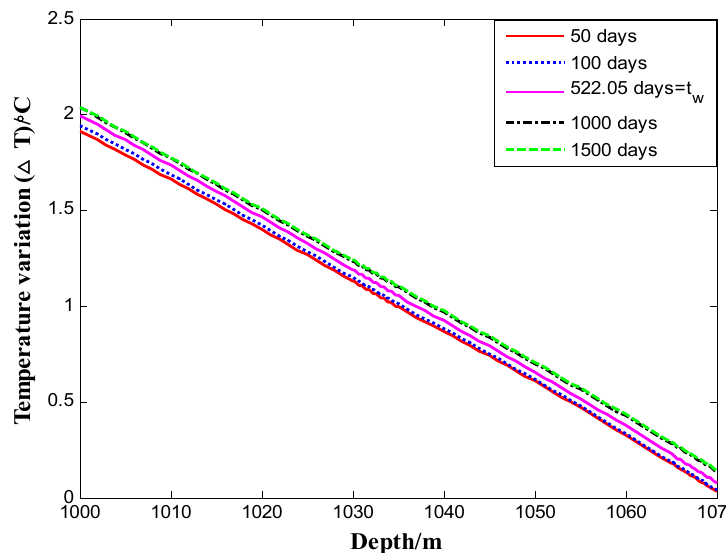
Figure 14. Tubing fluid temperature changes at the tubing-tubing wall interface ( r = 0.04 m, 1000 m ≤ z ≤ 1070 m) with different production time ( t ).